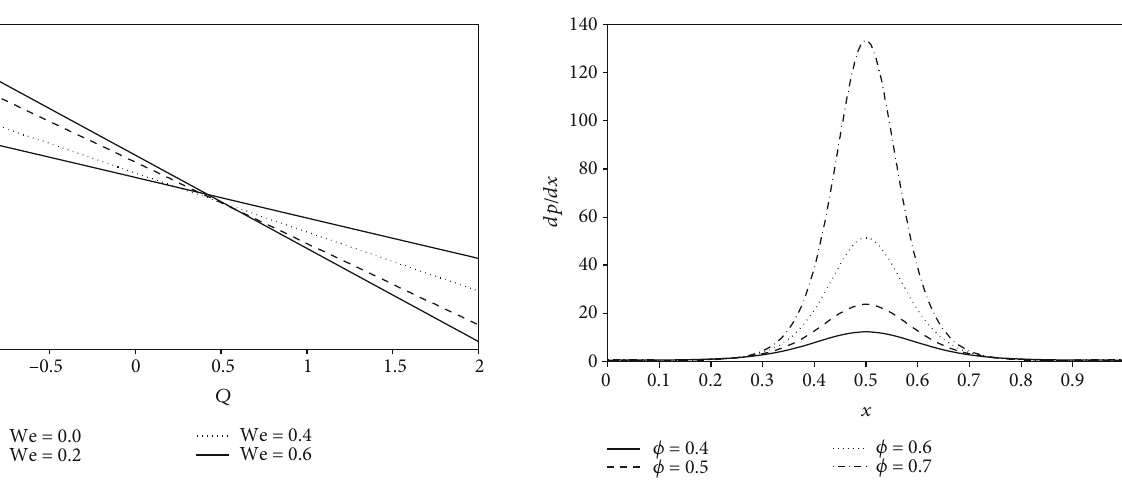
Figure 4: Variation of pressure rise with volume fl ow rate Q for di ff erent values of We for fi xed values of φ = 0 : 7 , n = 0 : 3 , and β = 6 .